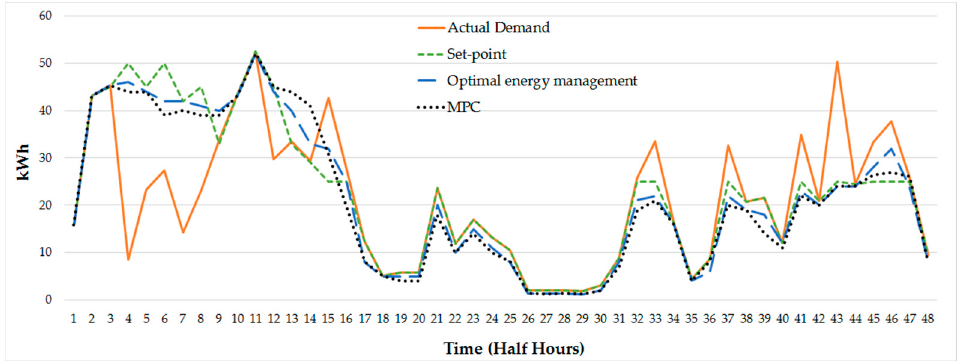
Figure 11. Specific example results: The actual demand, optimal energy management controller results and MPC controller results for one day.